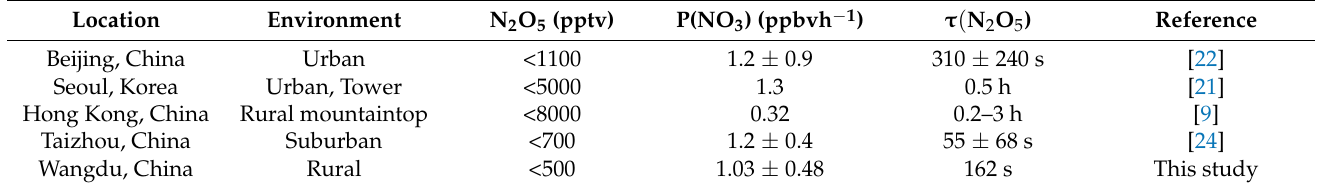
Figure 6. Time series for the NO 3 lifetime in Wangdu County, Hebei Province, from 10 June to 6 July. Table 1. The N 2 O 5 concentration and P(NO 3 ) and τ ( N 2 O 5 ) values in Wangdu and other observation sites.